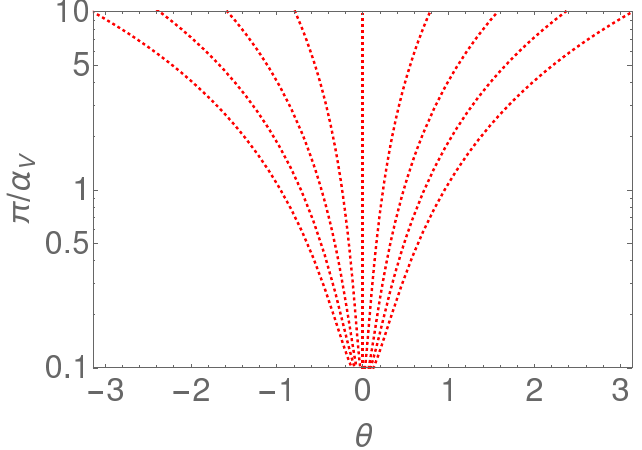
( θ , µ ) for different initial values of θ for t increasing from Figure 6: Flow of π/α V top to bottom.